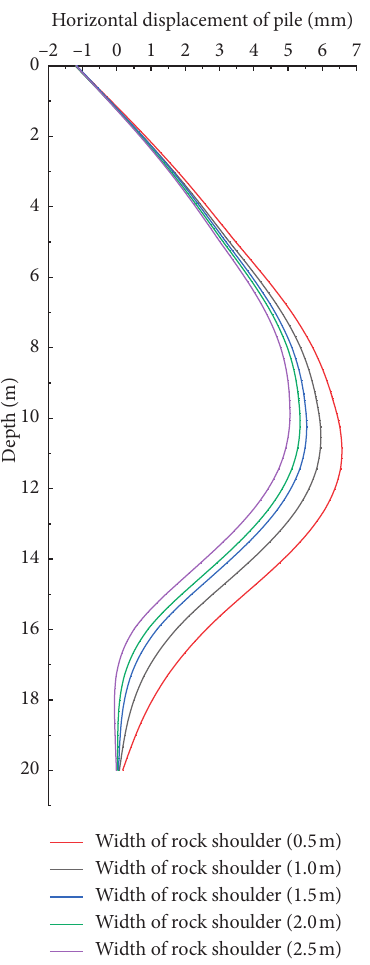
Figure 13: Horizontal displacement of the